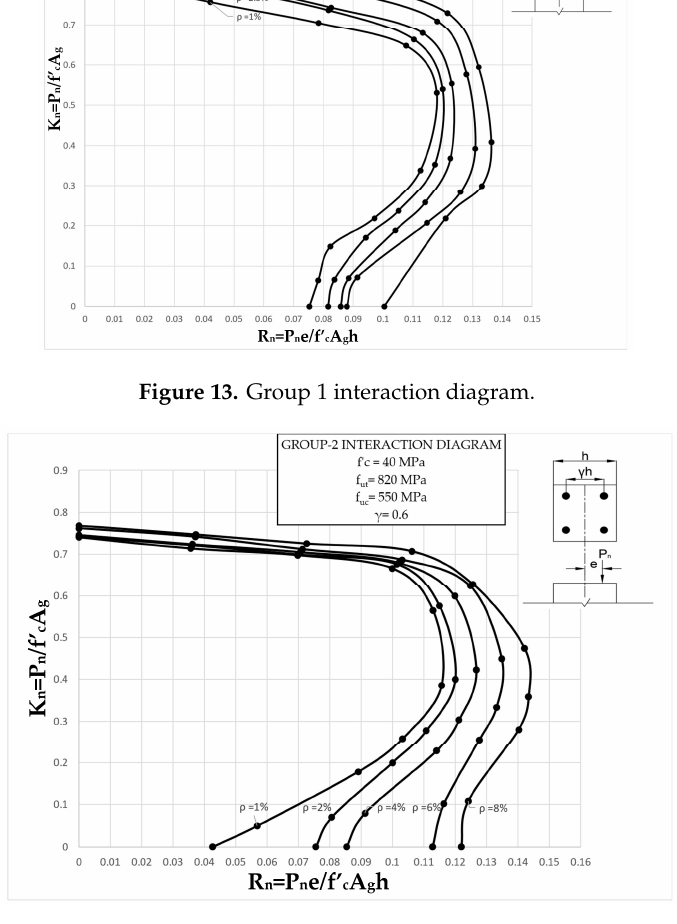
Figure 14. Group 2 interaction diagram.